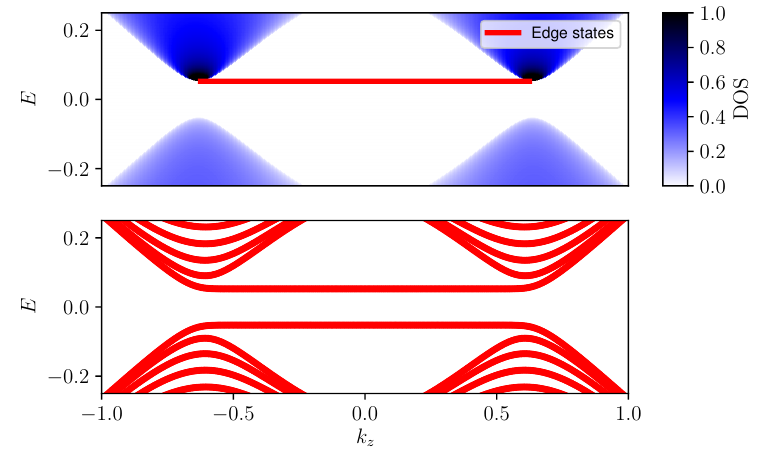
Figure 11: Upper panel: Color map of the DOS of the Weyl model and corresponding surface = π/ 120. Lower panel: Corre- states as a function of energy E and k for a fixed value of k z y sponding spectrum for a finite stack of 120 layers along the x direction. The parameters were = 1, µ = − 0.3, b = 0, β = 1.2. A similar simulation is featured in Ref. set to t = 2, t z 0